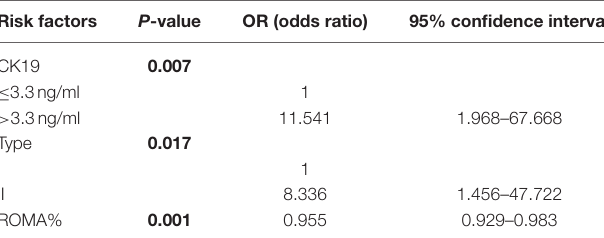
TABLE 3 | Pre-menopausal logistic multivariate analysis of ovarian metastasis and relevant risk factors.